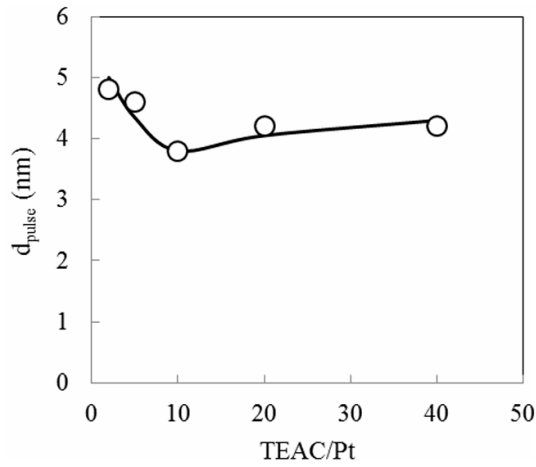
Figure 6. Effect of TEAC/Pt ratio on d pulse .